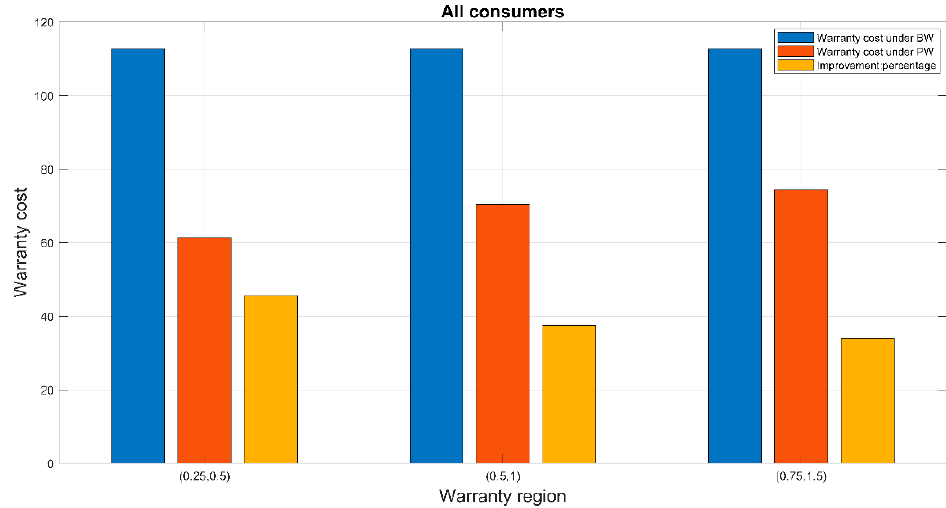
Figure 4. The effect of warranty region on the warranty cost.